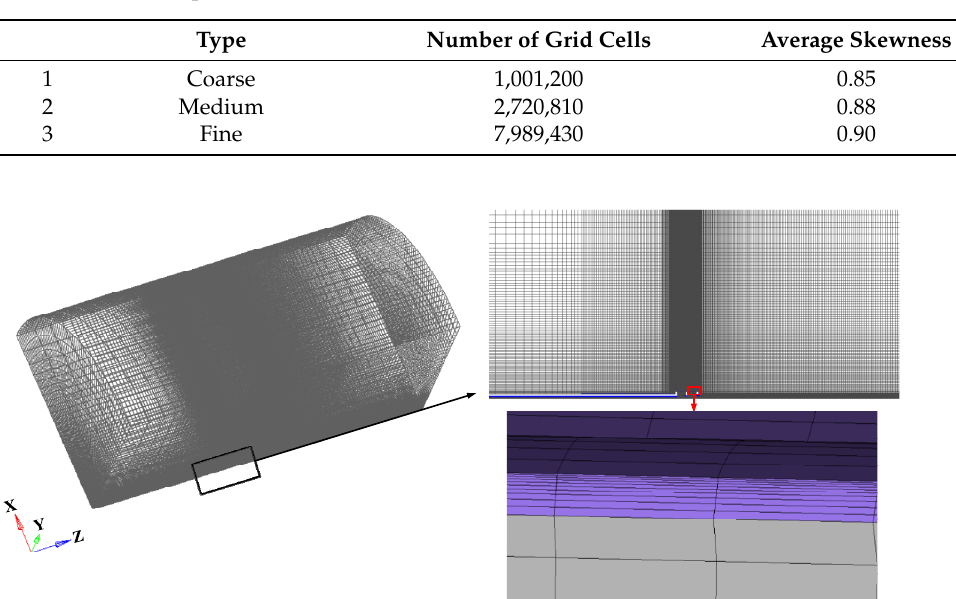
Figure 6. Receiver locations in the far fields.